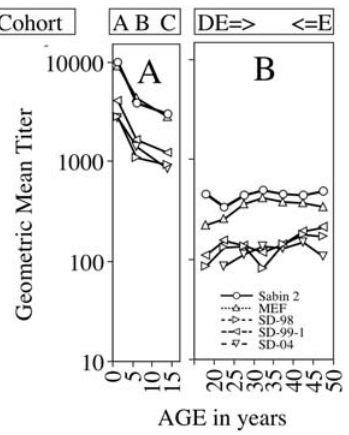
Figure 5. Geometric mean titers (GMT) of neutralizing antibodies against Type 2 strains by age group. The GMT for each strain was calculated for each age group after data was normalized by comparison to titers from a standard pool of 20 positive sera included in each analysis as described in Materials and Methods. The cohort (see Table 2) for which each GMT point was determined is shown at the top of the figure. The symbols for each isolate are in Fig. 5B. Fig. 5.A represents GMT of neutralizing antibodies to poliovirus in sera from cohorts aged 15 months to 15 years in which the complete immunization history of all individuals was documented. Fig. 5.B represents the GMT in sera from cohorts aged 18 years to 50 years from convenient samples obtained from the serum banks of the Israel Center for Disease Control (ICDC).